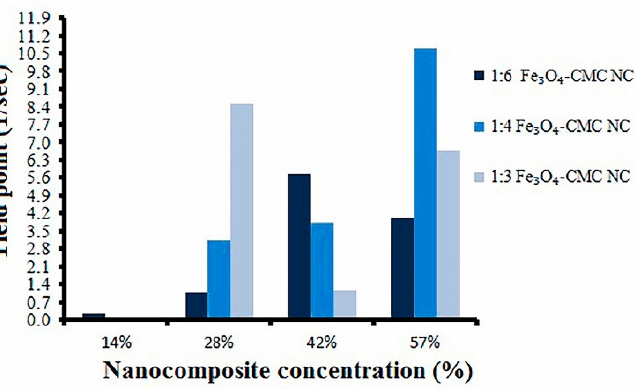
Figure 9. Yield point verses nanocomposite concentrations. Nanocomposite with the ratio 1:4 increased the yield point to a maximum of 50% compared to other ratios [107].